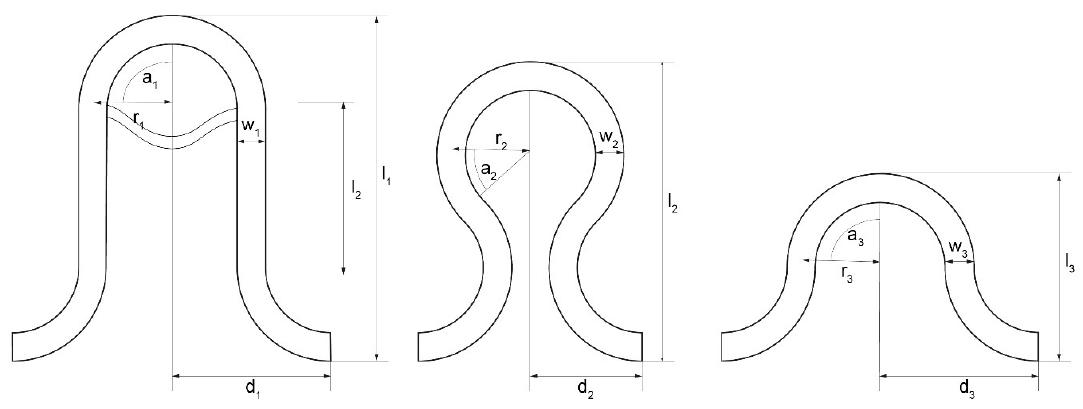
Figure 2. Dimensions of meanders (polyimide outline).